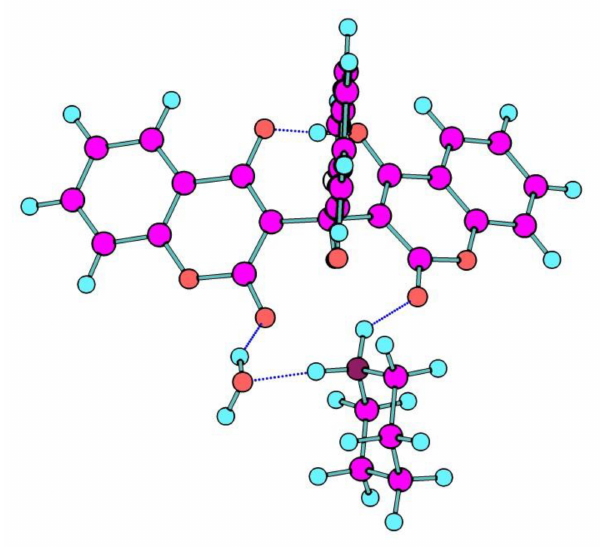
Figure 4. Gas-phase DFT optimized structures of compound at the B3LYP level of